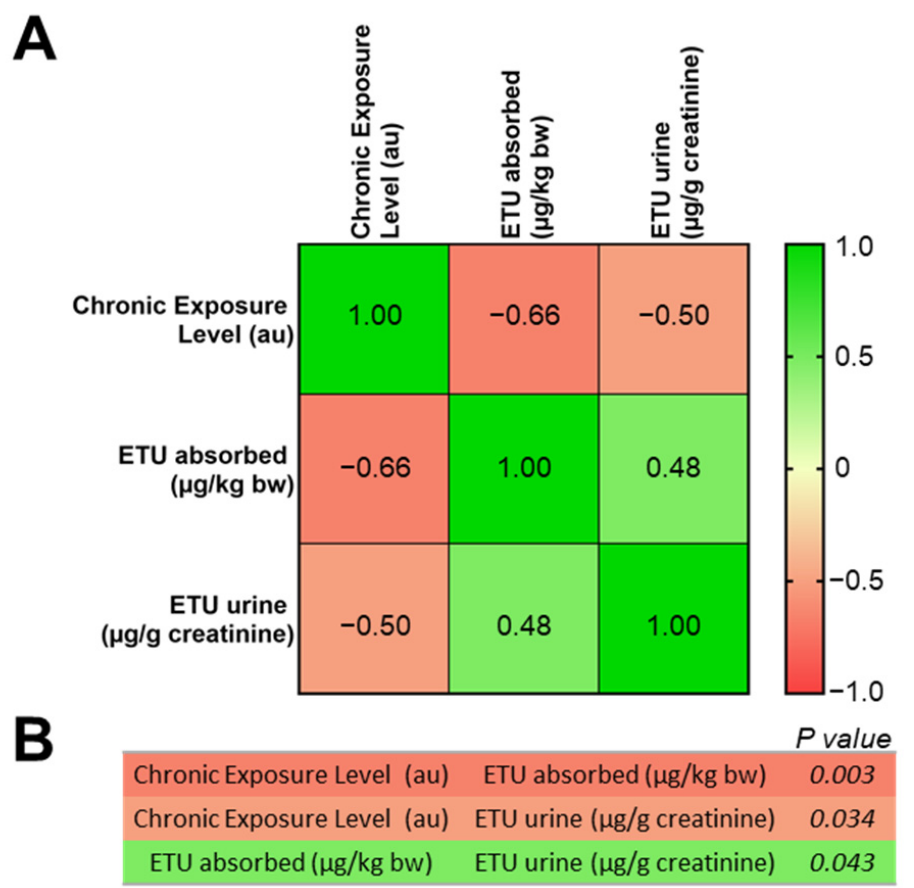
Figure 4. ETU exposure correlation matrix in greenhouse workers. ( A ) Spearman’s correlation matrix between chronic exposure levels (arbitrary units, au), ETU absorbed ( µ g/kg bw) and ETU measured in urine ( µ g/kg creatinine). Within each square, the corresponding r Spearman value is indicated, with associated color-code: green meaning a positive correlation, and red meaning a negative correlation. ( B ) p values corresponding to correlation values.